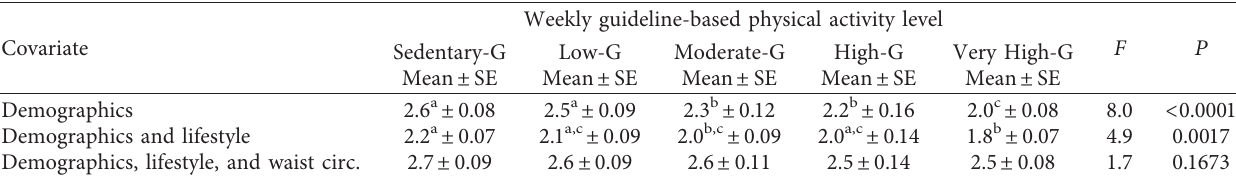
Table 3: Differences in mean HOMA-IR values by level of weekly guideline-based physical activity in US men and women, after adjusting for covariates.